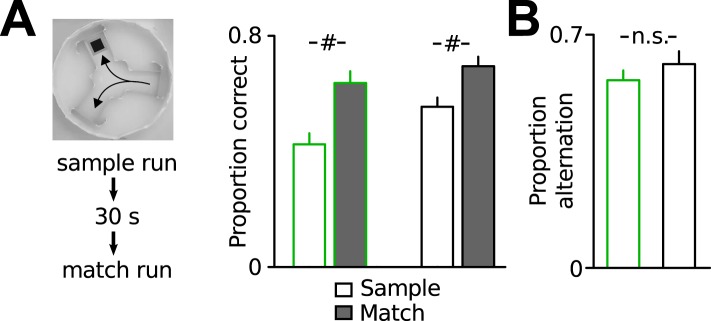
Additional assessment of working memory performance.(A) Working memory assessment in a delayed match-to-place task in the water y-maze. In each trial, animals had to find the hidden platform in one of the target arms (sample phase). After a 30 s delay, the mice were released from the same start arm (match phase) and could either choose the correct arm or the opposite arm (working memory error). Both Disc1 and control mice performed significantly better in the match phase, indicating intact spatial working memory (n = 6, 10). (B) Both genotypes showed similar spontaneous alternation when they explored a y-maze for 10 min, confirming intact working memory (n = 8 each group). #p < 0.001. Data are mean ± SEM.